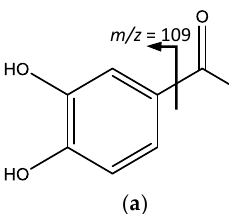
Figure 6. Flavonol glycosides structure and main fragments.